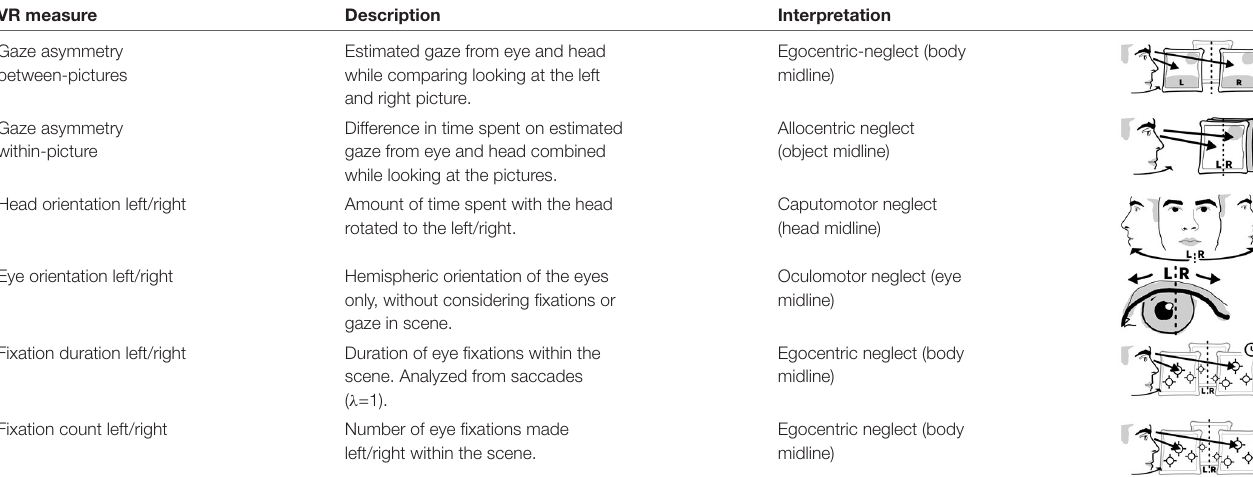
TABLE 1 | Virtual reality and eye tracking measurements.